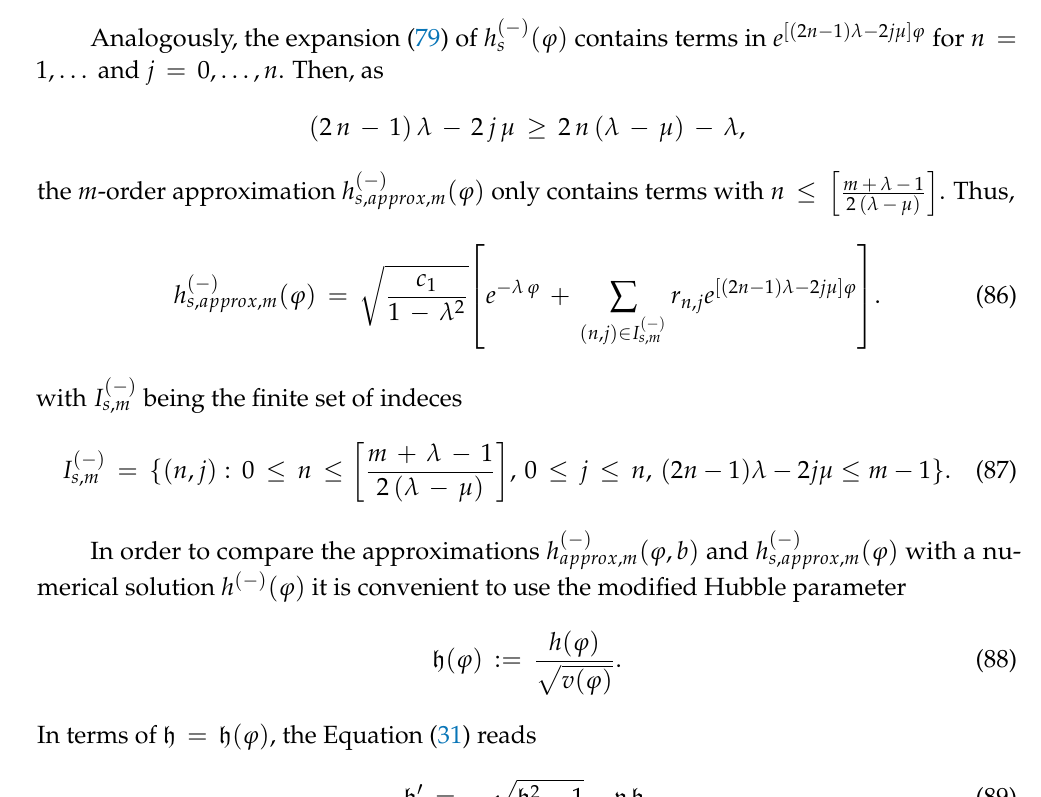
Figure 4. The green line shows the numerical solution of (17) with initial conditions ϕ 0 = 6, h 0 = h approx ,6 ( ϕ 0 , b 0 ) with b 0 = 1.48 × 10 7 . The black line shows the six order KD approximation (+) ) . The brown line shows the six order approximation h ( ϕ ) for the separatrix. ( ϕ , b h s , approx ,6 0 approx ,6 √ √ 3 2 The values of the parameters are λ = , µ = , c 1 = 2 × 10 − 10 , c 2 = 2.5 × 10 − 10 . We notice 3 4 that the green line (numerical approximation) overlappes the black line (KD approximation) in the KD region and overlappes the brown line (separatrix approximation) in the SR region. The region between the blue and red dotted lines is the inflation